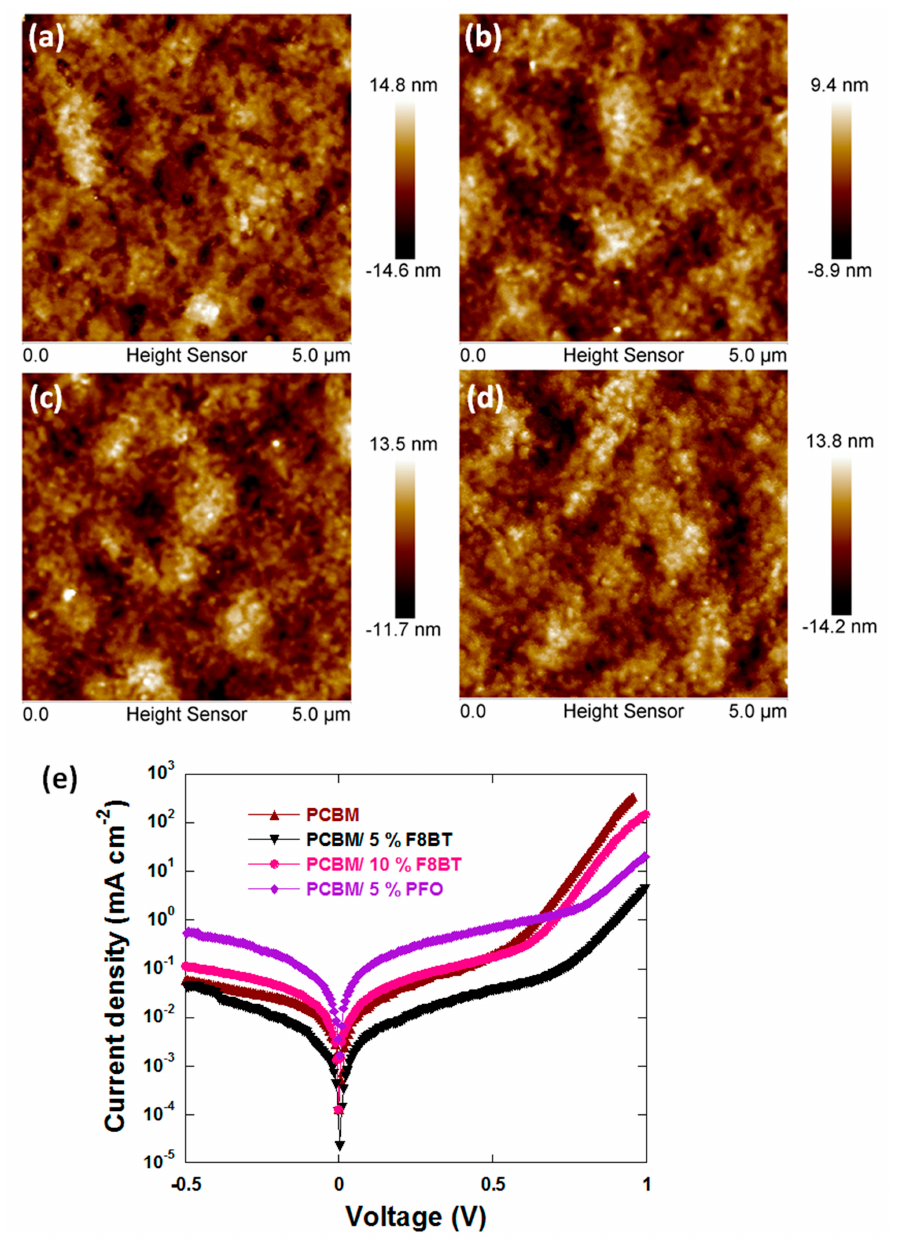
Figure 3. Atomic force microscopy (AFM) images of ( a ) PCBM, ( b ) PCBM: 5 wt % F8BT, ( c ) PCBM: 10 wt % F8BT and ( d ) PCBM: 5 wt % PFO, and ( e ) J–V characteristics of the device under dark with 0 wt % and 5 wt % F8BT.